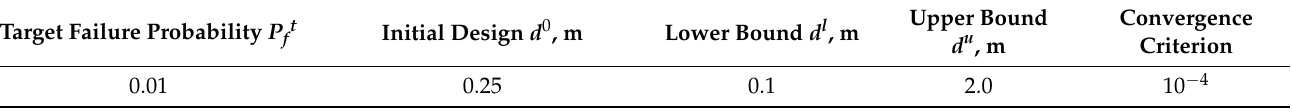
Table 2. Parameters for the target failure probability and optimization.